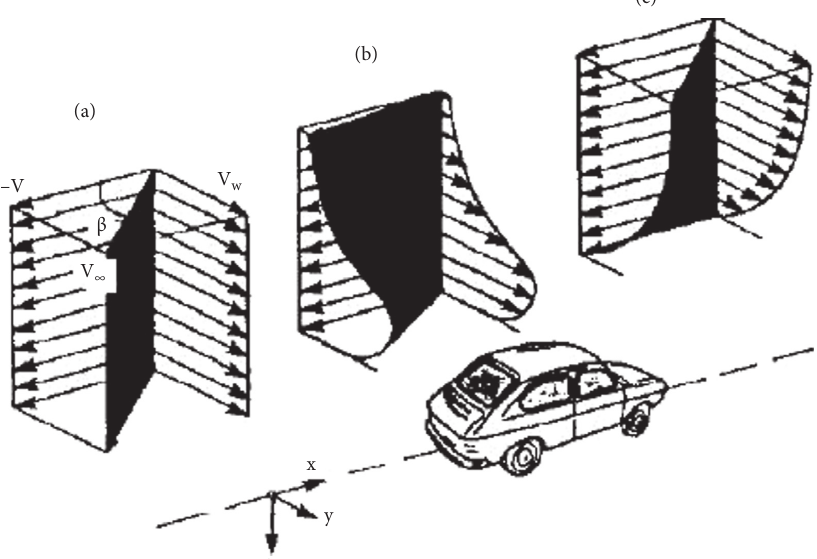
Figure 1: Comparison of artificial and natural speed characteristics [2].